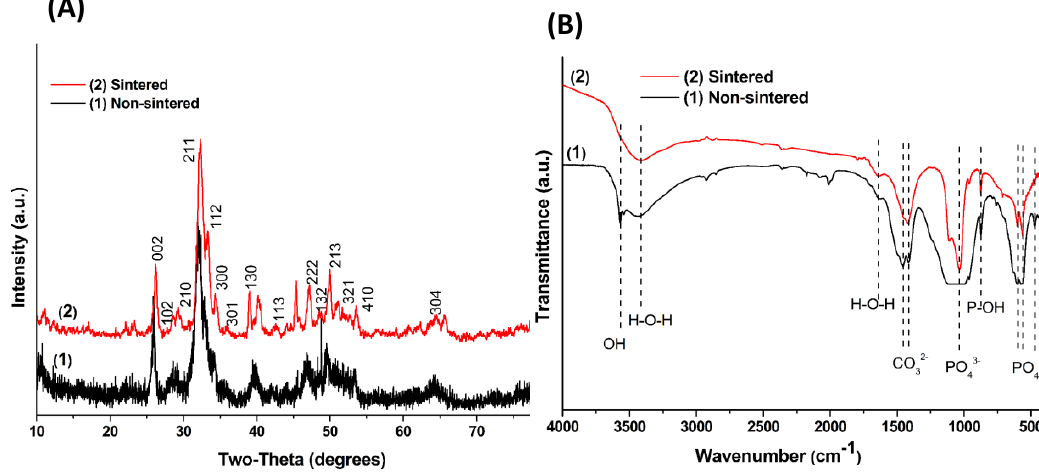
Figure 4. XRD ( A ) and FTIR ( B ) profiles of the fabricated HAp 2D plate-like nanostructure using FG extract.